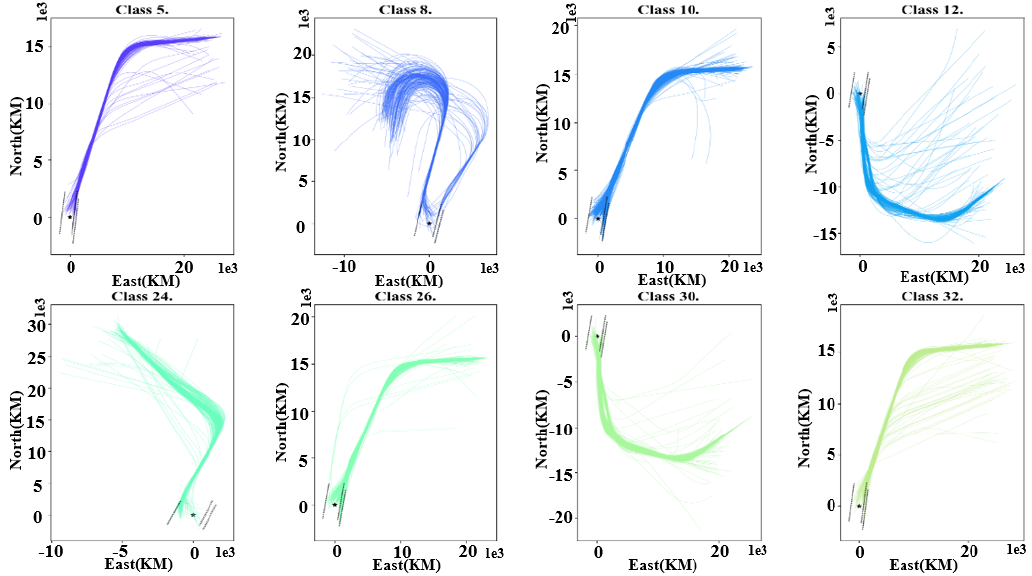
Figure 11. Visualize the clustering results of each class of departure trajectories.